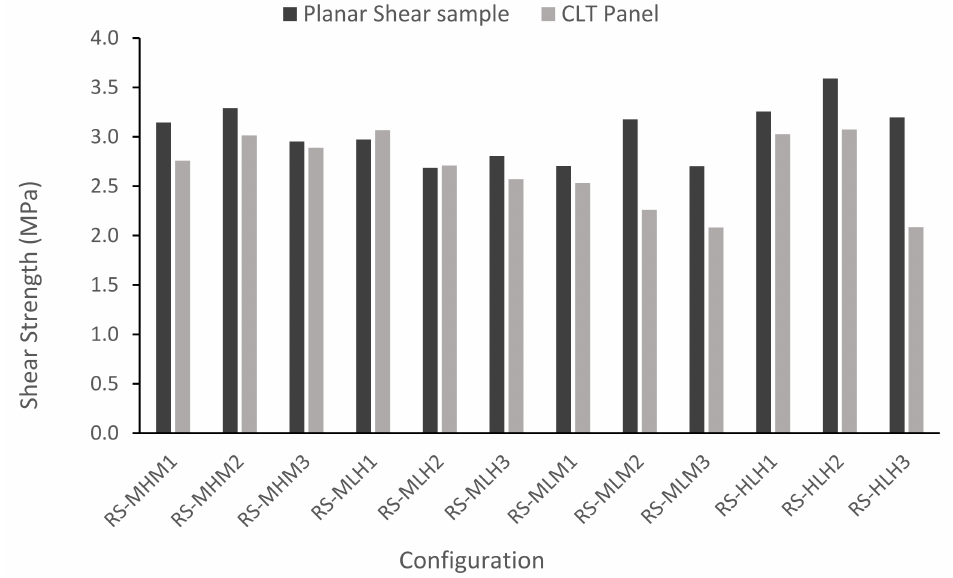
Figure 3. Average shear strength of the CLT panel vs. average shear strength of planar specimens.